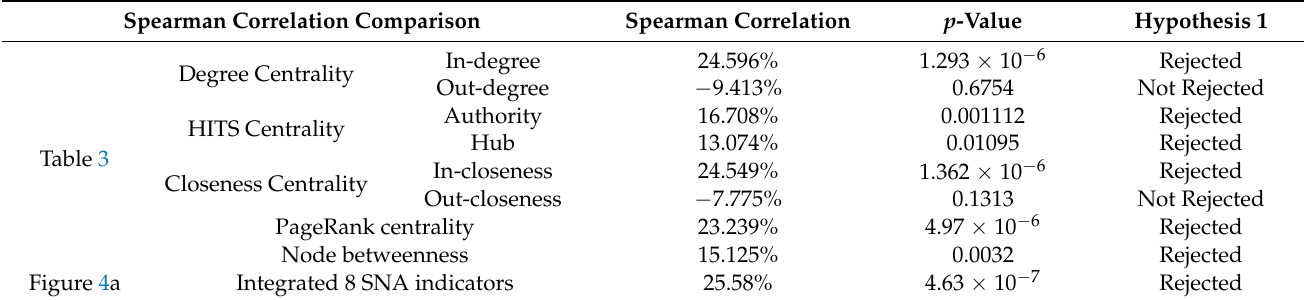
Table 7. The correlation between the derived function ranking and the network function ranking. Spearman Correlation